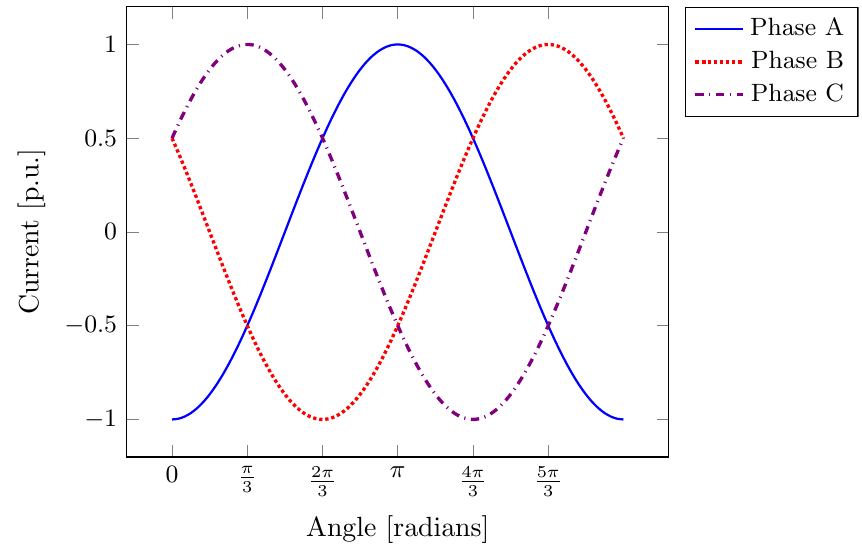
Figure 14. Extreme values location of current for each phase in one